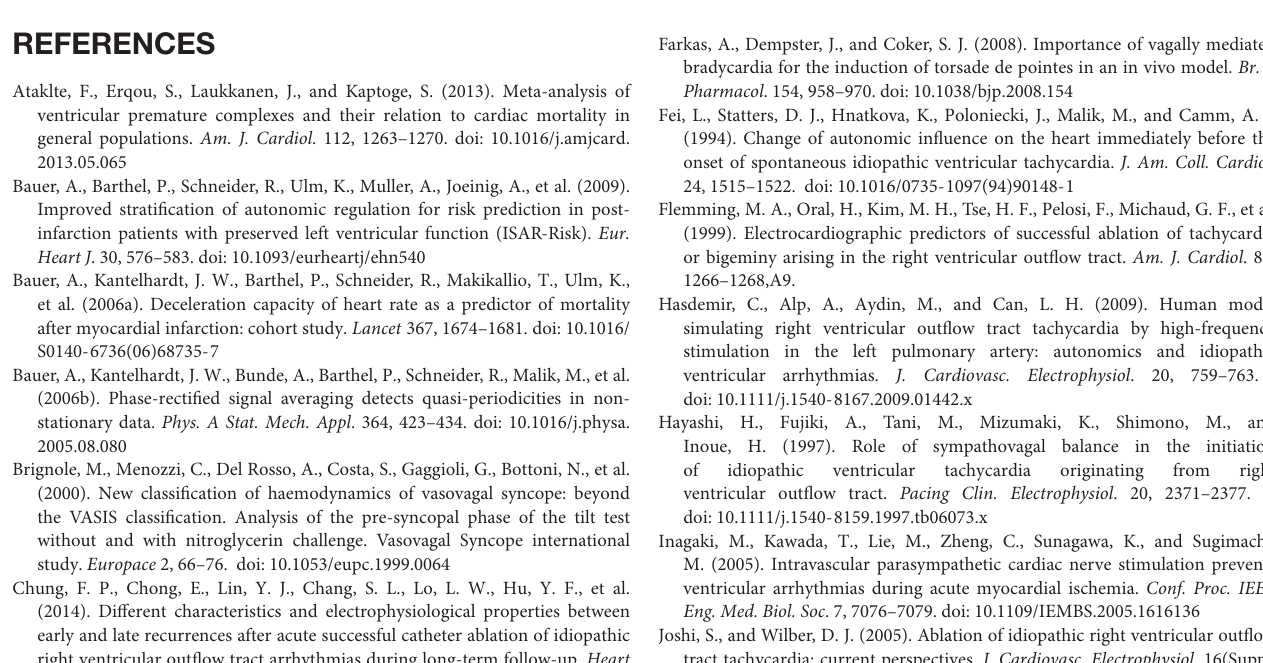
Supplementary Figure 1 | Study population and subgroups